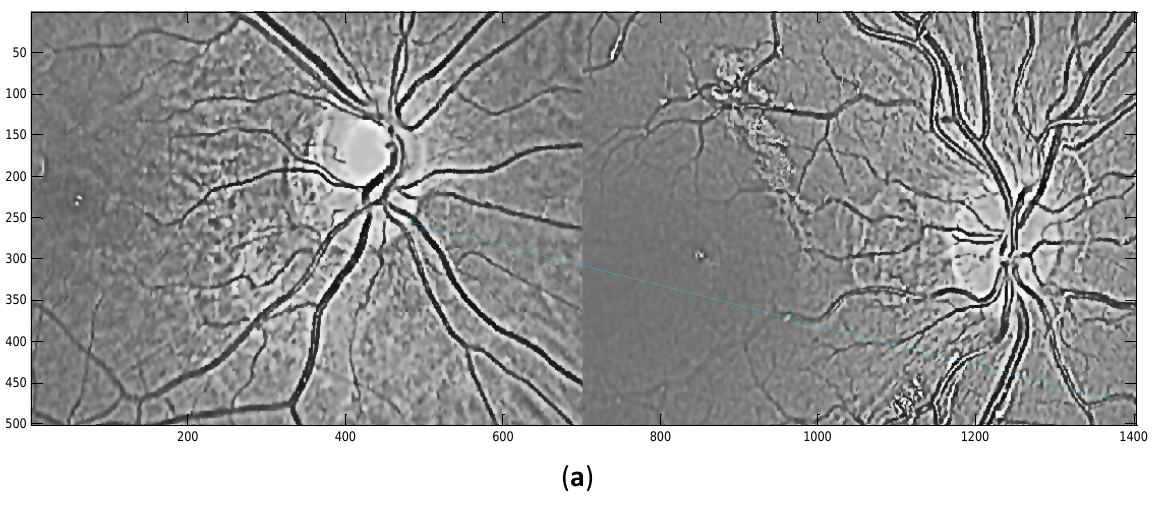
Figure 7. Exemplary matching results. ( a ) Imposter matching with very few (just one) matching pairs; ( b ) Genuine matching, with 142